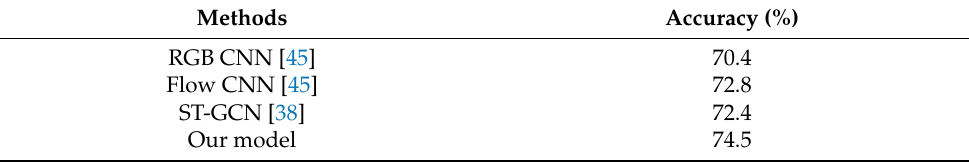
Table 6. Comparison of accuracy (%) with previous methods using Kinetics-Motion dataset.